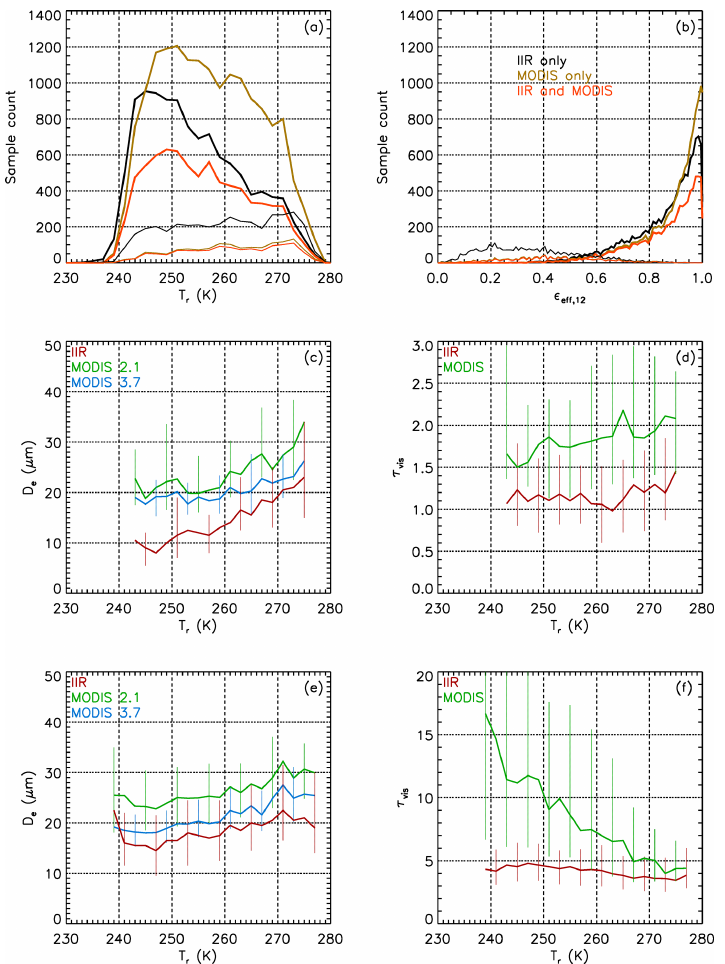
Figure 17. IIR and MODIS comparisons over oceans between 60 ◦ S and 60 ◦ N in January 2008 for single-layered high-confidence liquid water clouds of centroid altitude > 4km with MODIS water phase. Distributions of (a) IIR radiative temperature and (b) IIR effective emissivity at 12.05µm in ST (thin lines) and opaque (thick lines) clouds where IIR has confident retrievals (black), MODIS has successful retrievals at 2.1 and 3.7µm (brown), and both IIR and MODIS retrievals are successful and can be compared (orange). Median D e vs. T r from IIR (red), MODIS 2.1 (green) and MODIS 3.7 (blue) in ST (c) and opaque (e) clouds; median τ vis from IIR (red) and MODIS (green) in ST (d) and opaque (f) clouds. The vertical bars in panels (c–f) are between the 25th and 75th